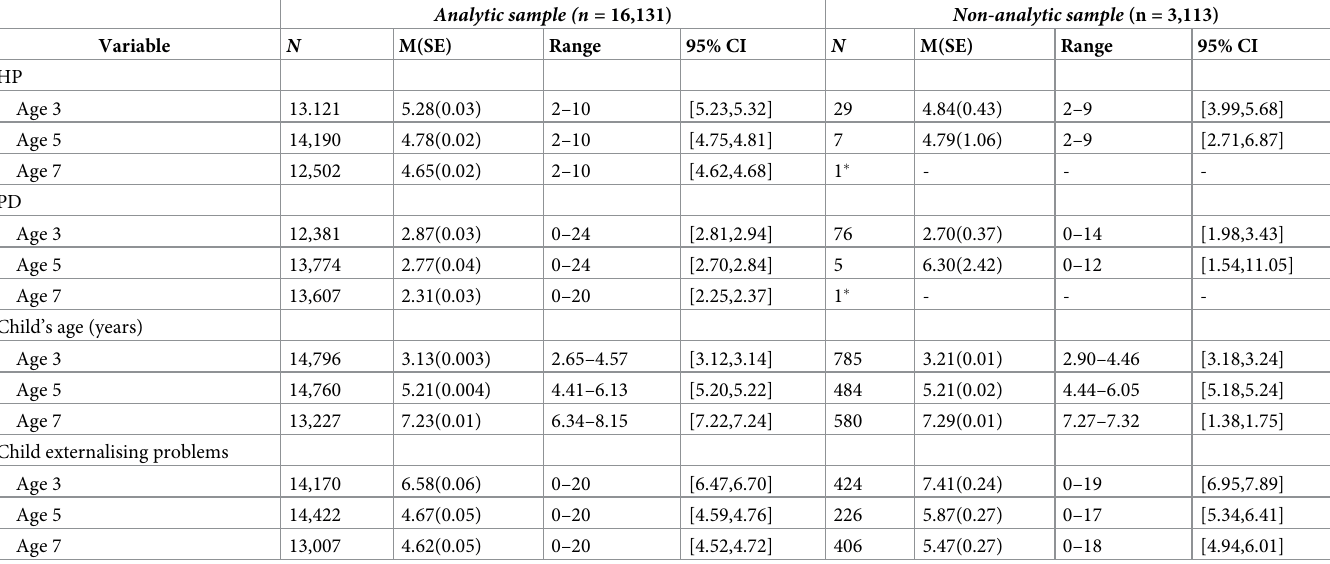
Table 2. Descriptives of continuous time-varying study variables in the analytic and non-analytic samples.